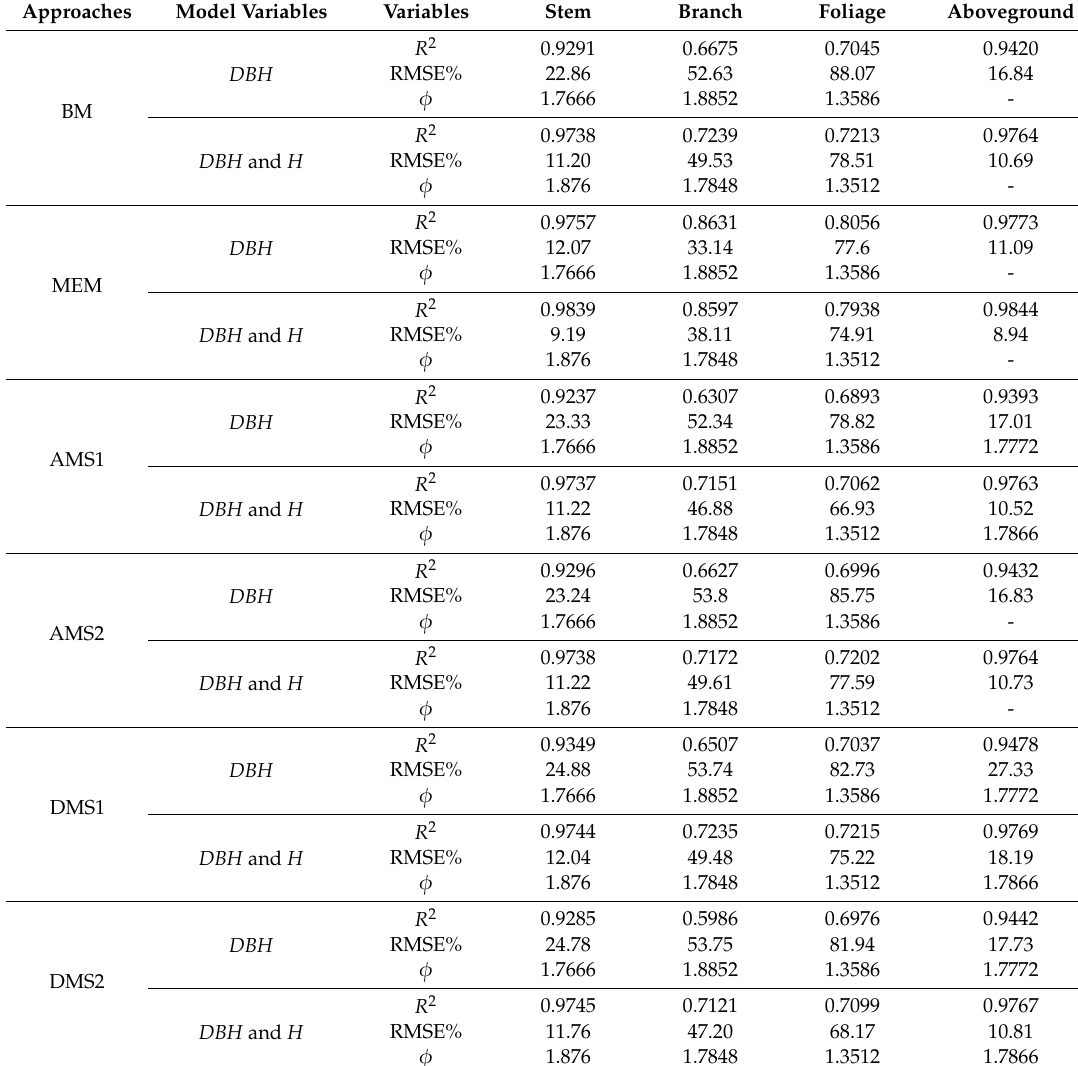
Table 5. Goodness-of-fit statistics and the parameter of weight functions ( φ ) for the biomass models developed using the BM, MEM, AMS1, AMS2, DMS1, and DMS2. Approaches Model Variables Variables Stem Branch